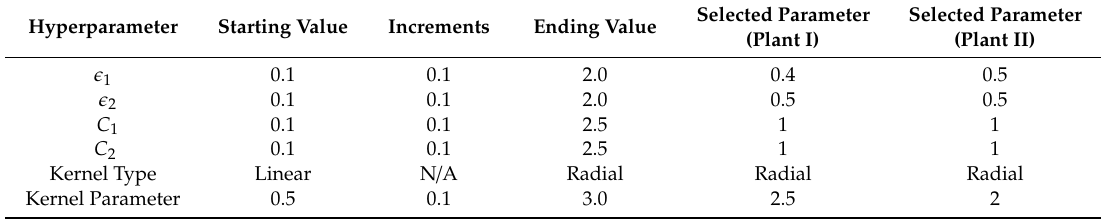
Table 3. Selection of Hyper-parameters for SVM for plant I and plant II.